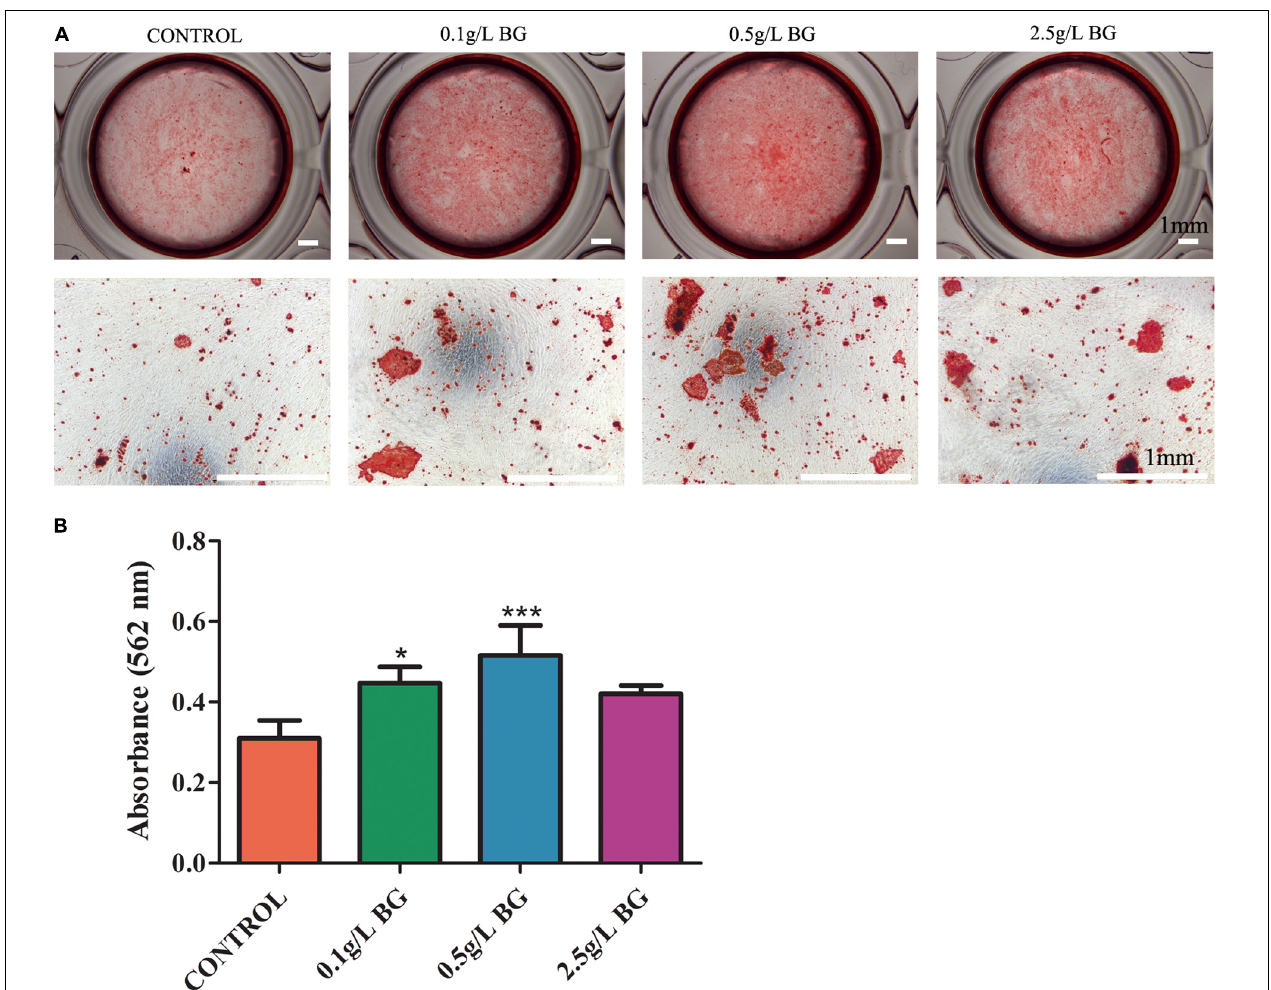
FIGURE 5 | Alizarin red staining for mineralized matrix in SHEDs cultures at day 14. (A) Representative images of alizarin red-stained mineralized matrix (scale bars: 1 mm). (B) Quantitative analysis of mineralized matrix. The data are presented as mean ± SD from 3 independent experiments ( n = 3). Significant effect of treatment compared to control, * P < 0.05, *** P <